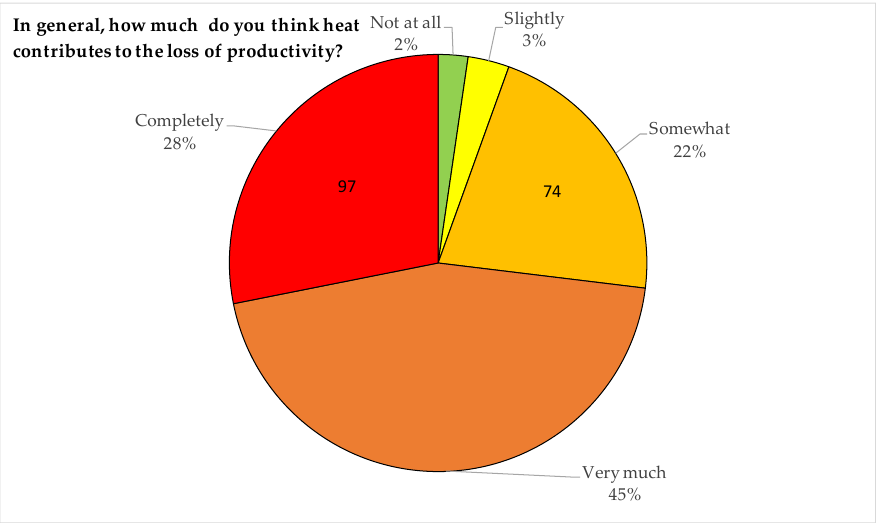
Fig 3. Frequencies and percentages of answers to the question 80 - In general, how much do you think heat Figure 3. Frequencies and percentages of answers to the question 80—In general, how much do you contributes to the loss of productivity? think heat contributes to the loss of